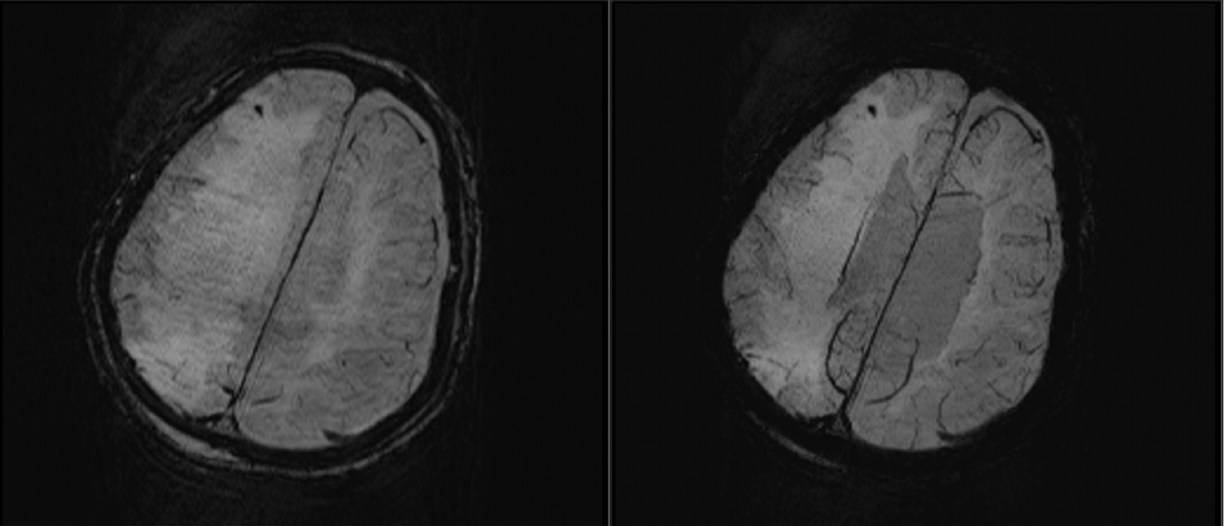
Figure 3. SWI obtained in a 90-year-old man after heat stroke with a score of 6 in Glasgow Coma Scale. On the 4th day after admission, amplitude (A) and minIP (B) images show punctate hemorrhage detected in right frontal lobe.